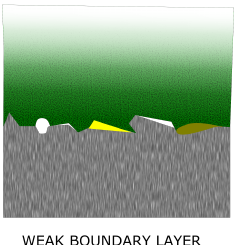
Figure 7. The weak boundary layer.